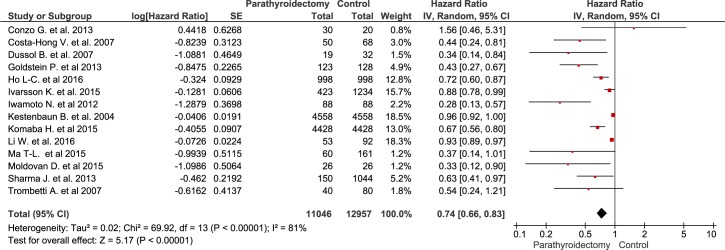
The effect of parathyroidectomy on all-cause mortality.